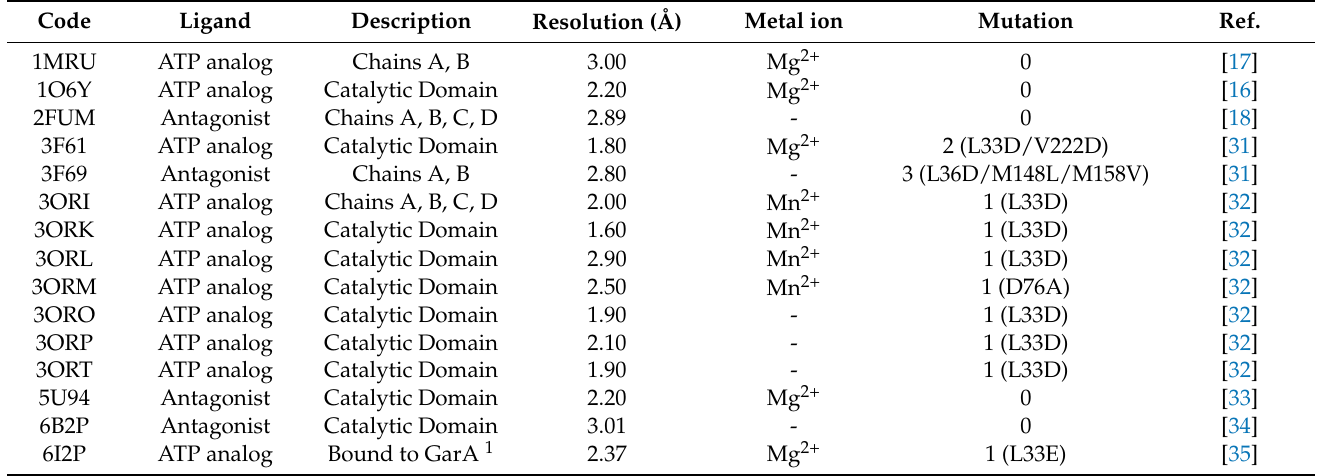
Table 1. Available structures of M. tuberculosis PknB on